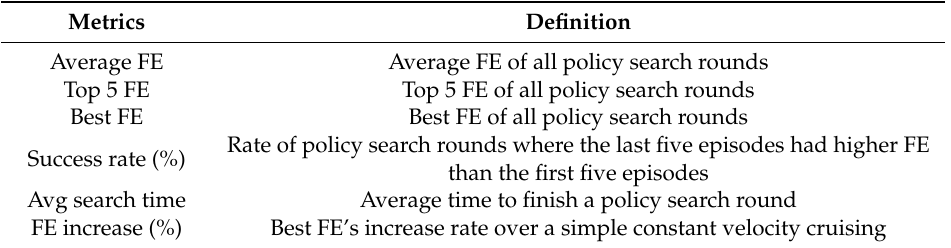
Table 3. Policy search round evaluation